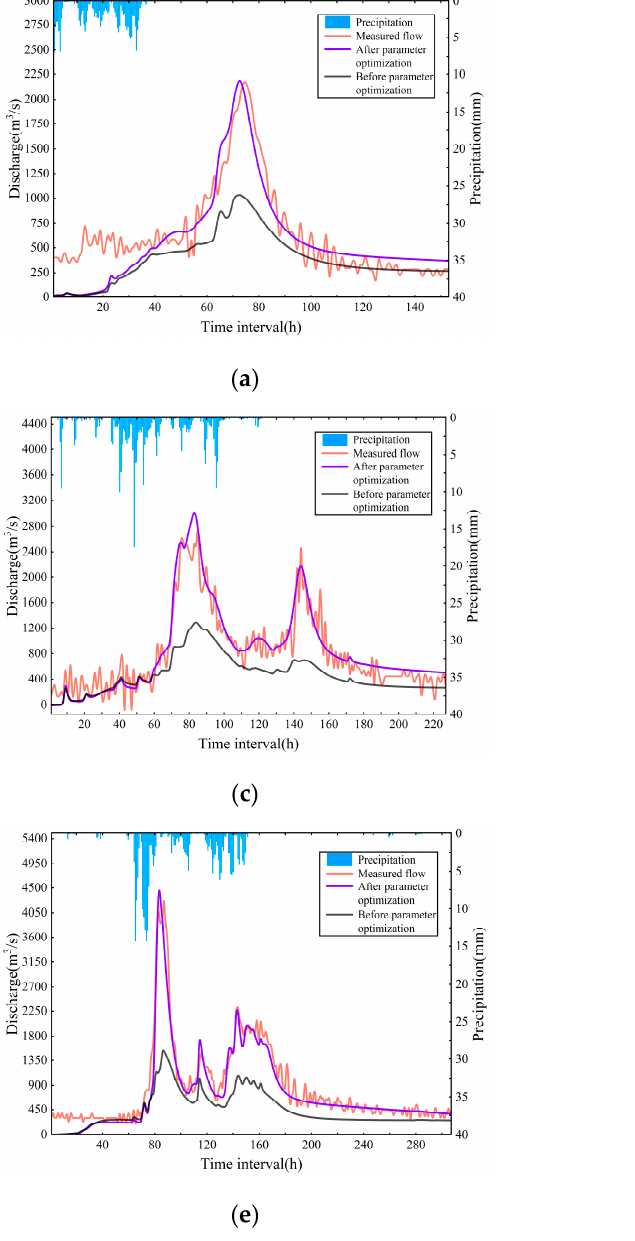
Figure 5. Representative floods with flood numbers: ( a ) 2011051315; ( b ) 2014051901; ( c ) 2016031715; ( d ) 2016041006; ( e ) 2019060702; and ( f ) 2019062017.